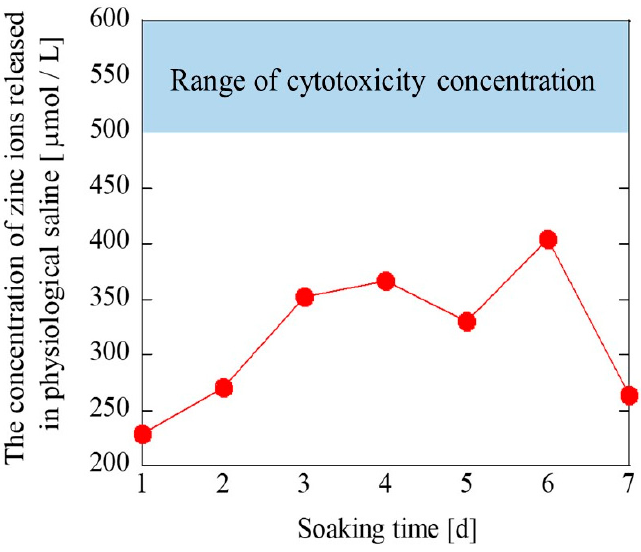
Figure 4. The release pro fi le of Zn 2+ ions released from the milled simonkolleite in physiological saline.